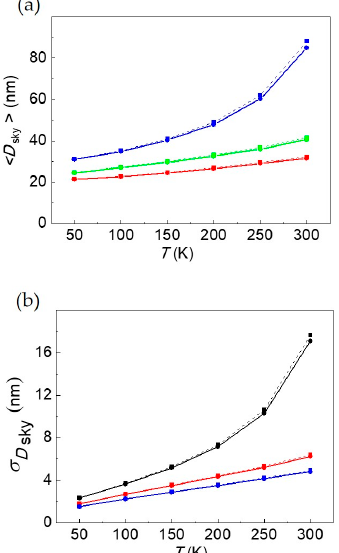
Figure 4. ( a ) 2D (solid lines) and 3D (from Table 1 of [14]) (dashed lines) average skyrmion diameters as a function of T for μ 0 H ext = 0 mT (blue lines); μ 0 H ext = 25 mT (green lines) and μ 0 H ext = 50 mT (red lines); ( b ) standard deviation of the 2D (continuous lines) and 3D (dashed lines) distribution (from Figure 4 of [13]) as a function of T for μ 0 H ext = 0 mT (black lines); μ 0 H ext = 25 mT (red lines) and μ 0 H ext = 50 mT (blue lines).